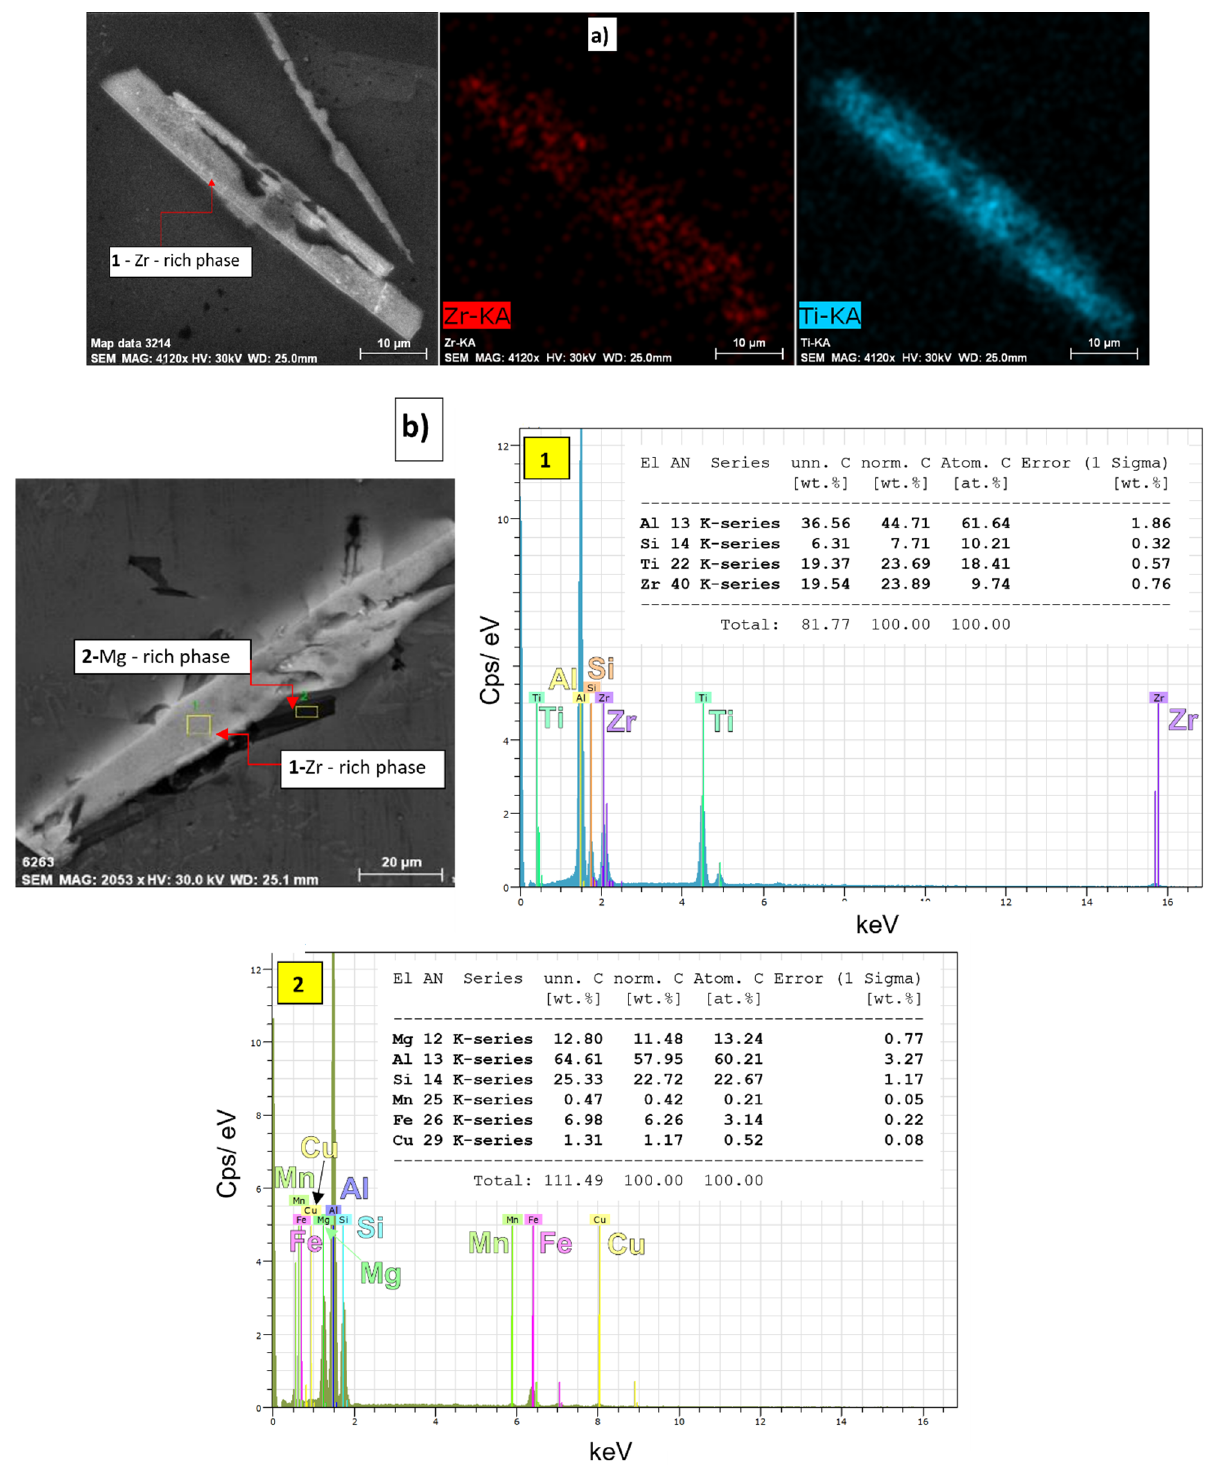
Figure 7. Identification of Zr-rich phases in the primary alloy P, SEM; ( a ) Mapping, ( b ) EDX analysis. In contrast to the P alloy, there was no significant disintegration of Zr phases (Figure 6b,d,f) after heat treatment. It can be concluded that finer, evenly distributed intermetallic Zr phases have a reinforcing effect in the AlSi7Mg0.3Cu0.5 alloy. In the case of experi- mental alloys E1 to E3 (Figure 8), it is possible to observe a decrease in ductile matrix disruption due to the precipitation of a much larger number of Zr phases than in the case of the P alloy. Although the size of the fission facets is slightly smaller than in the case of